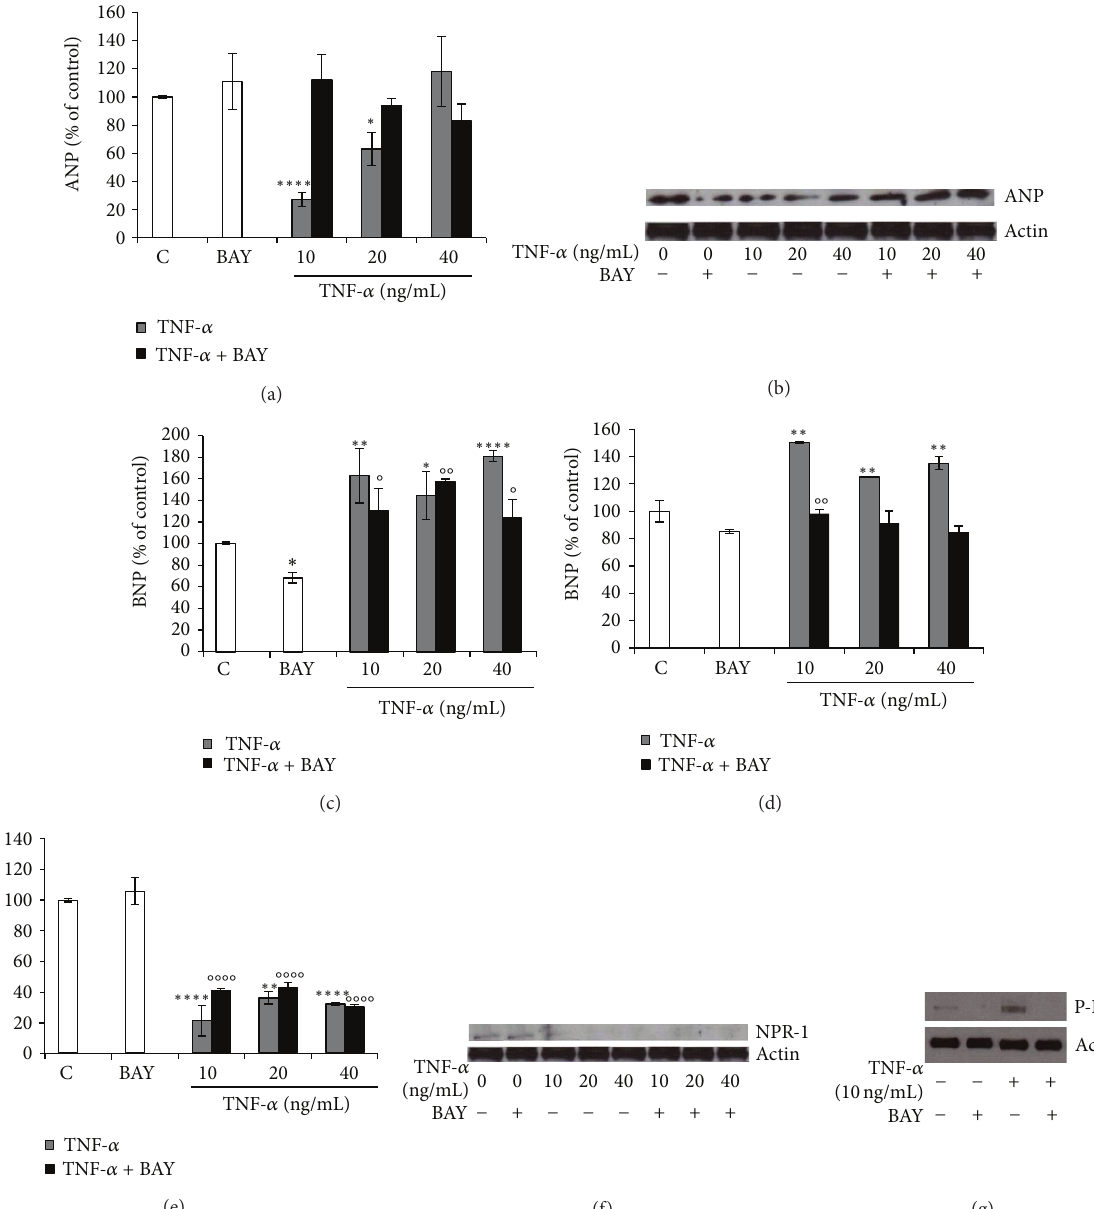
Figure 3: TNF- 𝛼 modulation of NPs and NPR-1 may require activation of NF- 𝜅 B pathway . BEAS-2B cells were treated with 10, 20, and 40ng/mL TNF- 𝛼 alone or in combination with NF- 𝜅 B inhibitor BAY 11-7082 (1 𝜇 M), for 24 h. ((a), (b)) ANP, ((c), (d)) BNP, ((e), (f)) NPR-1 gene expression at mRNA ((a), (c), and (e)) and protein level ((b), (d), (f)), and (g) Phospho-I 𝜅 B- 𝛼 protein level. Western blots were obtained by using the specific rabbit polyclonal or monoclonal Abs. The blots were stripped of the bound Ab and reprobed with mouse anti- 𝛽 -actin, to confirm equal loading. Western blots are representative of three separate experiments. All histograms indicate means ± SD of three different cultures each of one tested in quadruplicate and expressed as percentage of control ( ∗ 𝑃 < 0.05 , ∗∗ 𝑃 < 0.01 , ∗∗∗∗ 𝑃 < 0.0001 versus Controls). ( ∘ 𝑃 < 0.05 , ∘∘ 𝑃 < 0.01 , and ∘∘∘∘ 𝑃 < 0.0001 versus BAY). C: Controls (untreated